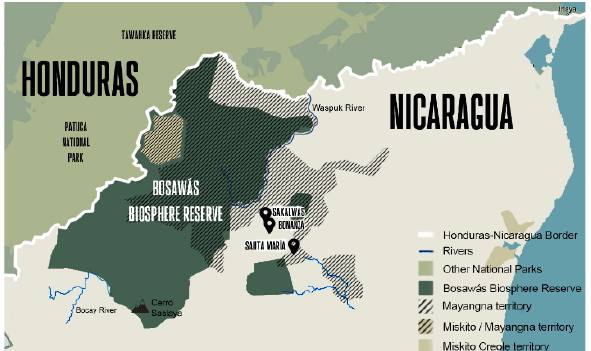
Figure 1. Location map of the Bosawás Biosphere Reserve and Mayangna territories in the North Caribbean Coast Autonomous Region,